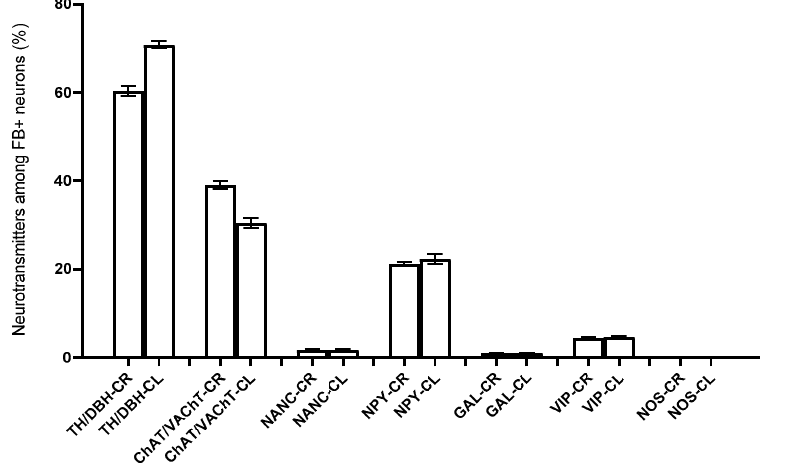
Figure 3. Percentage of FB+ neurons containing particular substances and neuropeptides located in the right (R) and left (L) APG of the control animals (C); There were no non-statistically (ns) significant differences ( p > 0.05).